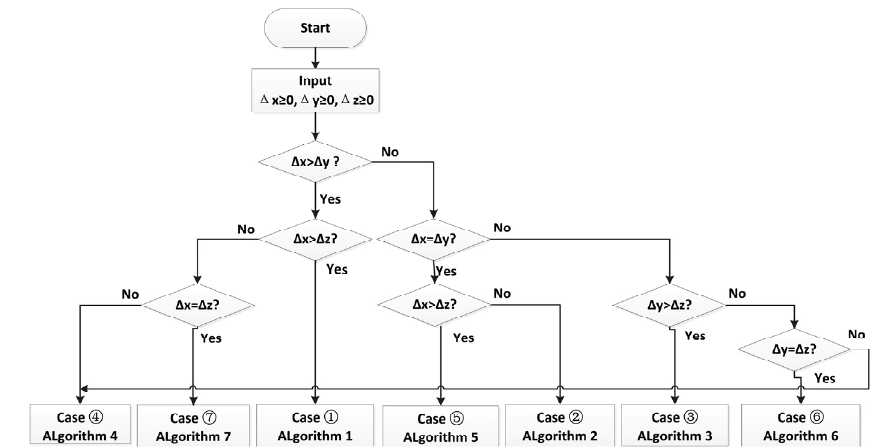
Figure 3. Flow chart for judging the distribution of straight lines in three-dimensional space.